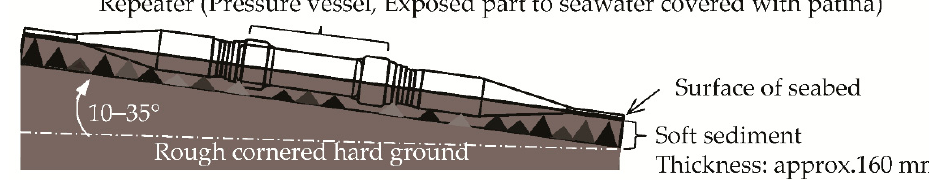
Figure 22. Repeater sitting on the subduction zone or the seabed of the Emperor Seamounts.